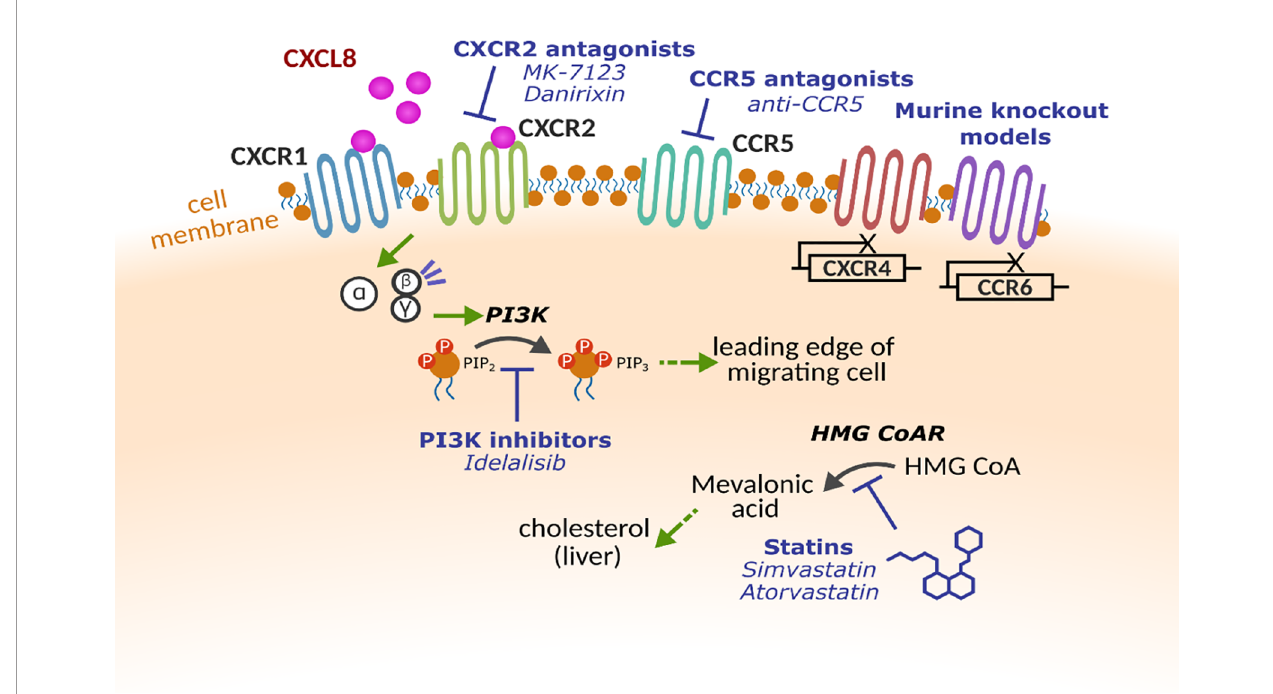
FIGURE 2 | Molecular targets for altering leukocyte traf fi cking. Multiple receptors and proteins have been targeted to alter leukocyte traf fi cking. Chemokine receptors CXCR1, CXCR2, CXCR4 CCR5 and CCR6 have all been investigated either using pharmacological intervention or in early studies with gene knockout models. Within the cell, key enzymes such as phosphoinositide 3-kinase (PI3K) and b -Hydroxy b -methylglutaryl-CoA reductase (HMG CoAR) that have been implicated in cell